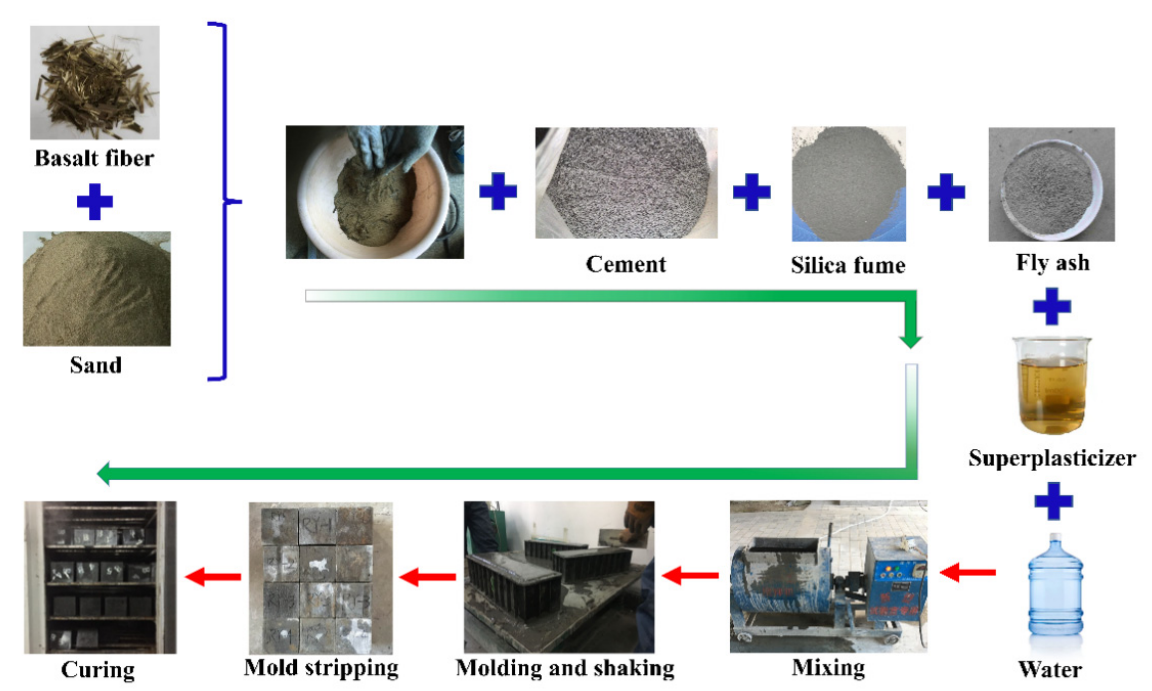
Figure 3. Sample preparation process.